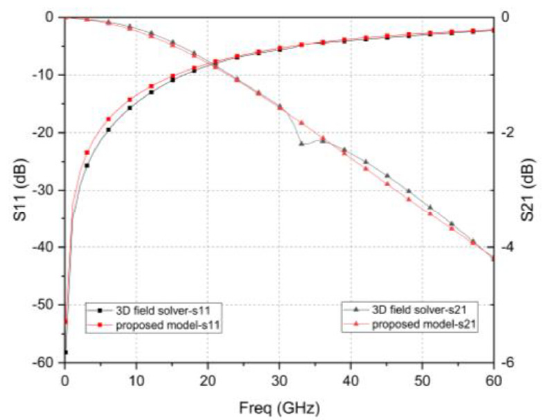
Figure 5. S-parameters results of dual redundant TSV structure obtained by 3D FEM solver and equivalent circuit model.